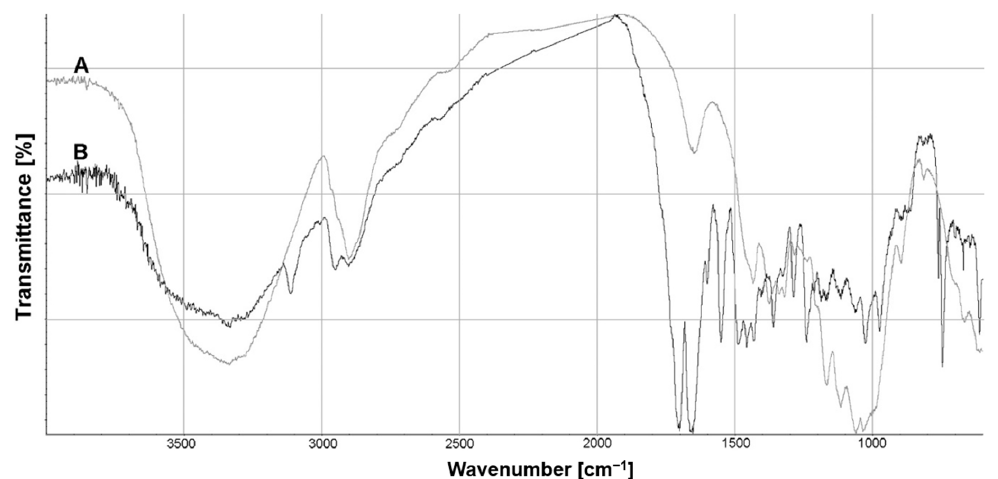
Figure A2. FTIR spectra of the mixture of cellulose (A) and the mixture of cellulose with caffeine (B) from the 4000 to 400 cm − 1 range.